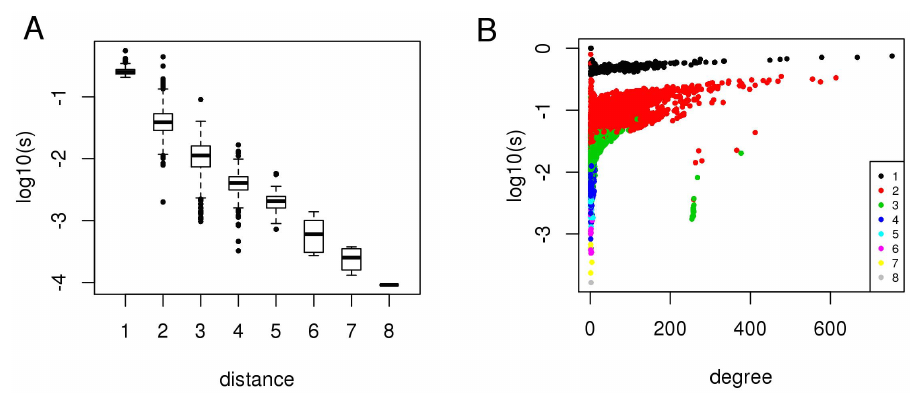
Figure 1. The network proximity score of a protein depends on network distance from viral targets and protein degree. A ) Boxplots of network proximity scores (log 10 , vertical axis) grouped by viral-host protein network distance (horizontal axis). B ) Network proximity scores (log 10 , vertical axis) distributed by protein degree (horizontal axis); colors indicate viral-host protein network distance.